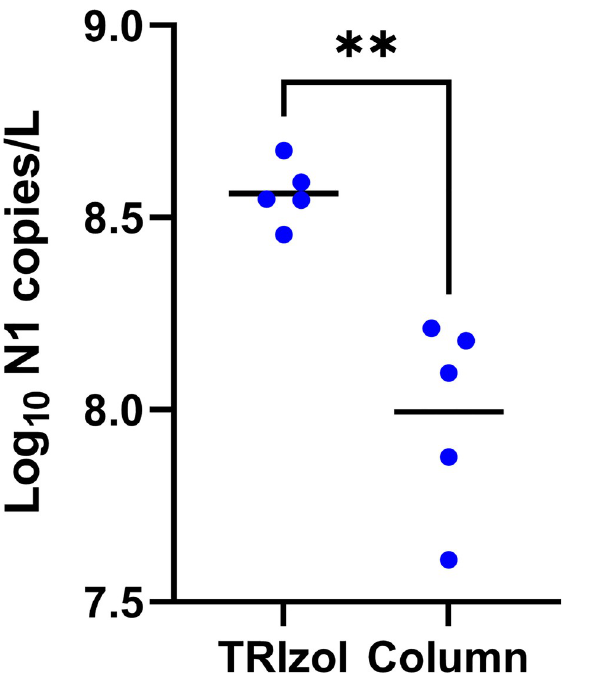
Fig 6. Effect of TRIzol extraction: Copy number yield for the N1 target for 24-hr composite wastewater samples obtained from 5 wastewater treatment plants. Each point in the mean of 2 technical replicate measurements from a 24-hour composite sample. Horizontal black lines show means. See Fig 2 legend for explanation of pairwise comparisons.